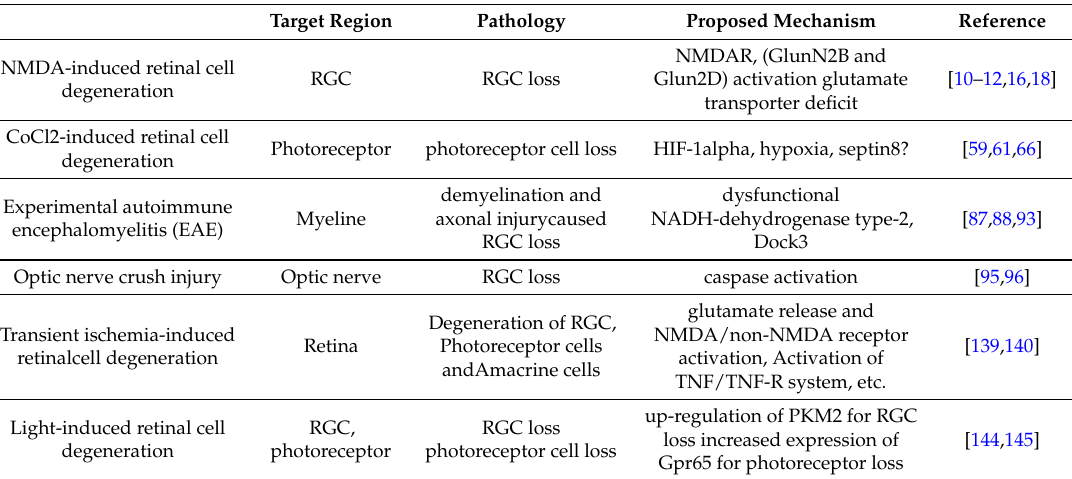
Table 1. Summary of animal models for retinal cell